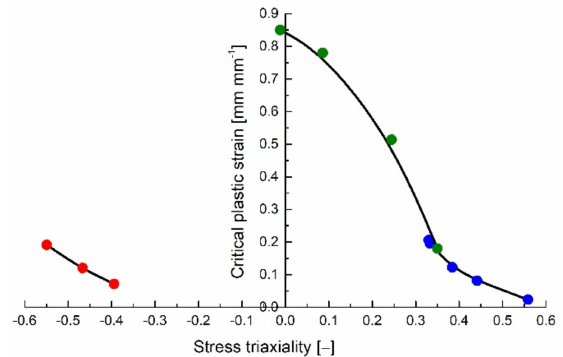
Figure 18. Variation of the critical plastic strain with stress triaxialities for all the investigated types of